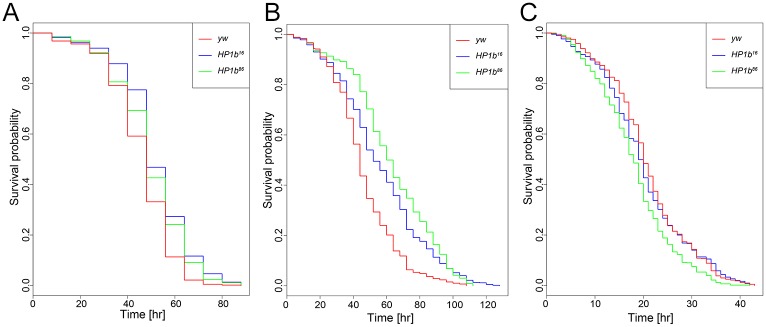
Loss of HP1B increases survival during starvation and oxidative stress, but not during heat stress.A. HP1b mutant animals survive significantly longer during starvation condition than yw control animals (p = 1.022e-13 and p = 7.188e-06 for HP1b16 and HP1b86, respectively, Kruskal-Wallis rank sum test). B. HP1b mutant animals survive significantly longer after exposure to the oxidizer paraquat than yw control animals (p = 3.057e-13 and p < 2.2e-16, for HP1b16 and HP1b86, respectively, Kruskal-Wallis rank sum test). C. HP1b mutant animals do not show improved survival during heat stress conditions (37°C) compared to yw control animals. In contrast, they show lower survival (p = 0.04158 and p = 1.874e-09, for HP1b16 and HP1b86, respectively, Kruskal-Wallis rank sum test).